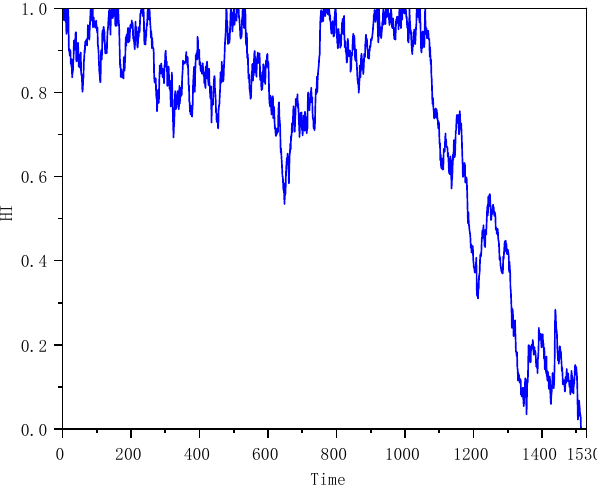
Figure 8. Curve of Bearing Degradation Process.